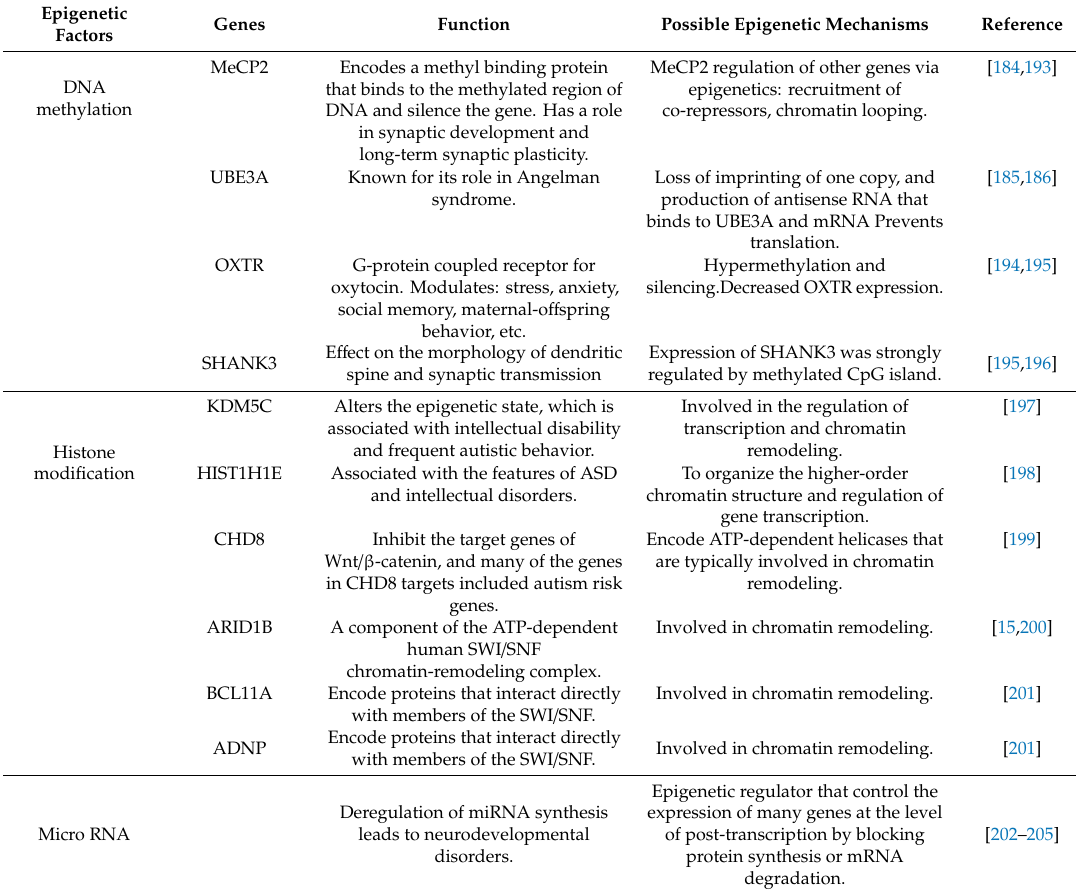
Table 2. Epigenetic factors implicated in